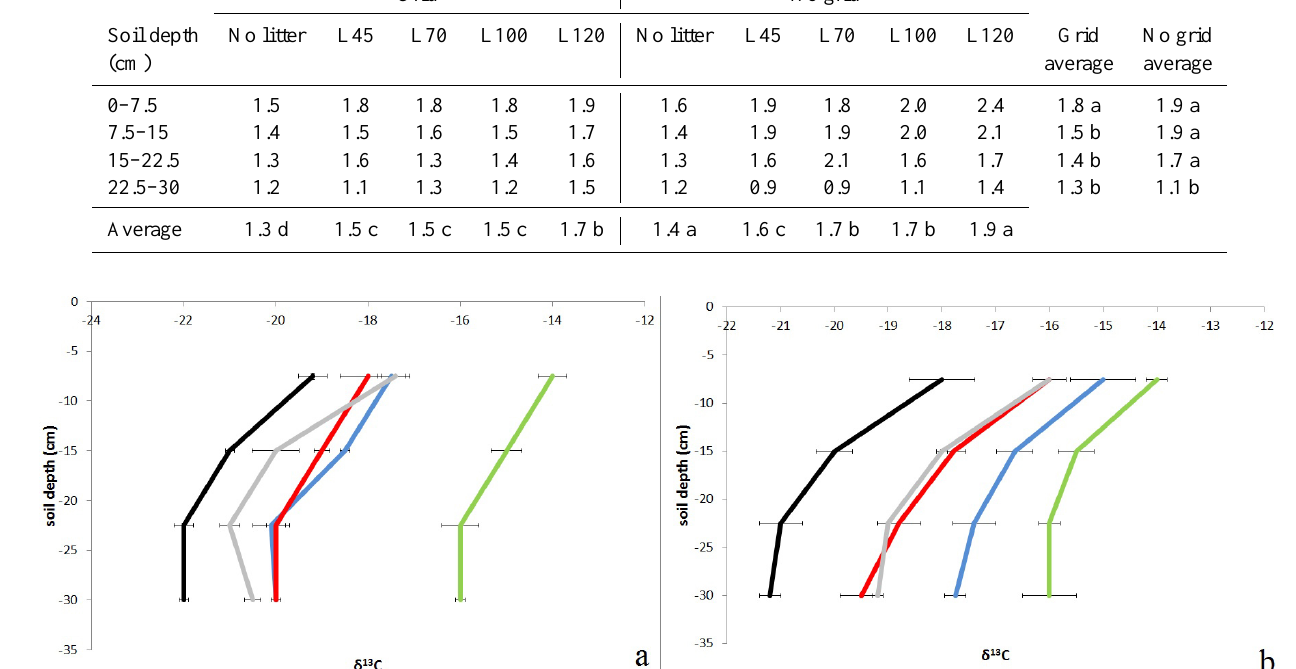
Figure 3. δ 13 C value at different depth in no grid (a) and grid (b) treatment. The green line represents no litter treatment, while blue, red, grey and black represent litter in fields abandoned for 120, 100, 70 and 40 years,